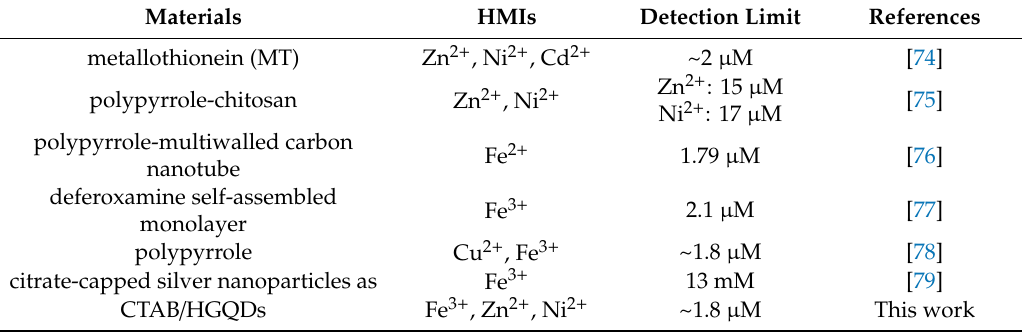
Figure 12. Resonance angle shift of CTAB/HGQDs thin film with different metal ion. Table 1. Comparison of SPR-based sensor for heavy metal ions (HMIs) detection.